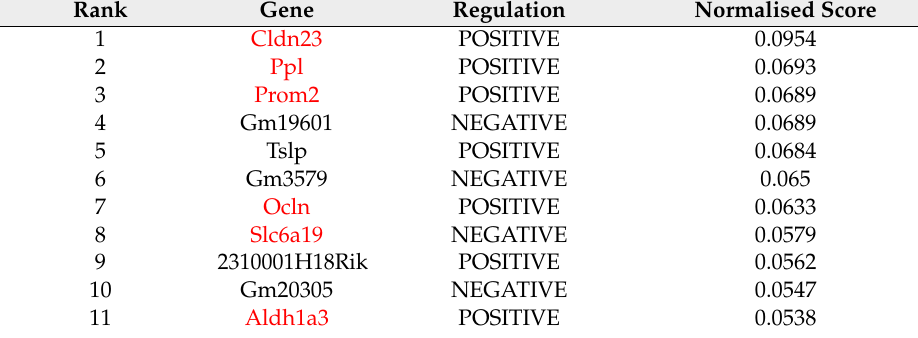
Table 5. The top 50 most di ff erentially regulated genes in primary epithelia following modulation of grh / Grhl function. Orthologues of the genes highlighted in red were screened and validated in subsequent Q-RT-PCR experiments in grhl3 - / -